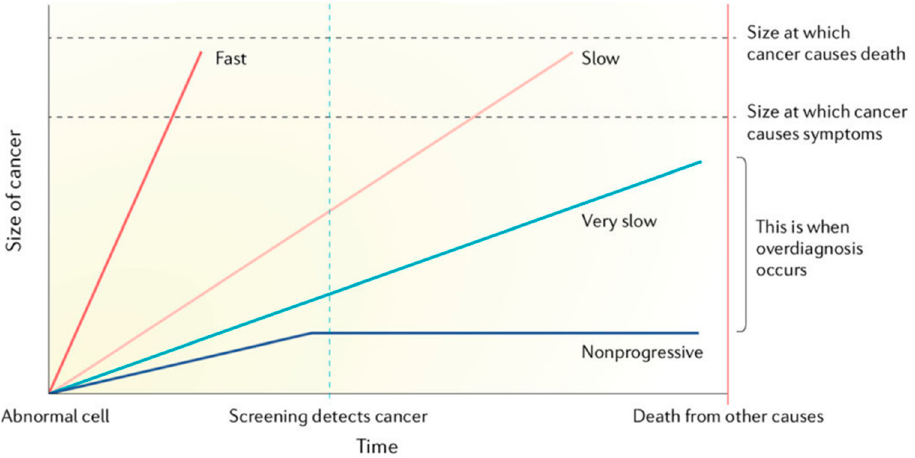
Figure 1. Slow versus rapid progressors—unpredictable tumour growth trajectory. (From Welch [1], as adapted by NCI Division of Cancer Prevention [3]).